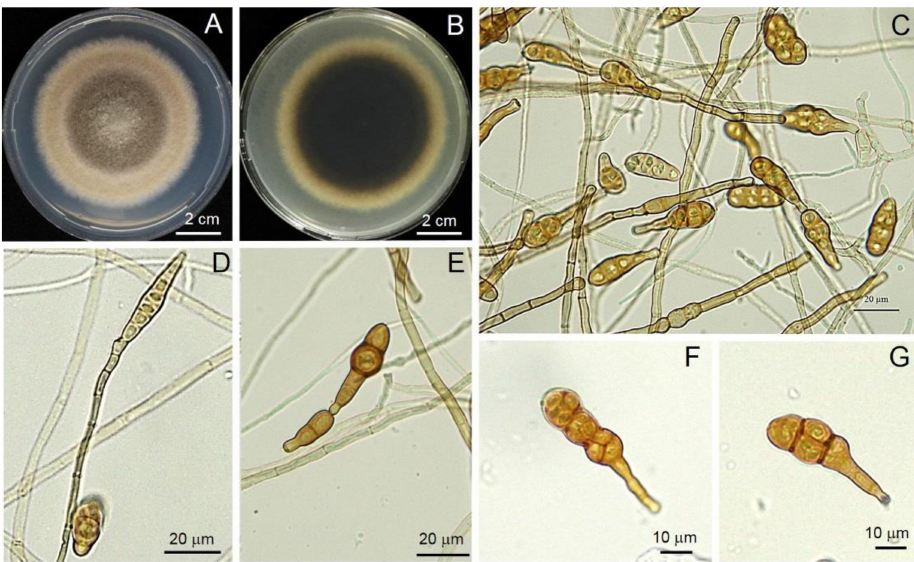
Figure 3. General morphology of Alternaria sp. (Al01): Colony on PDA from the top ( A ) and bottom view ( B ); hyphae and diverse shape of conidia ( C – G